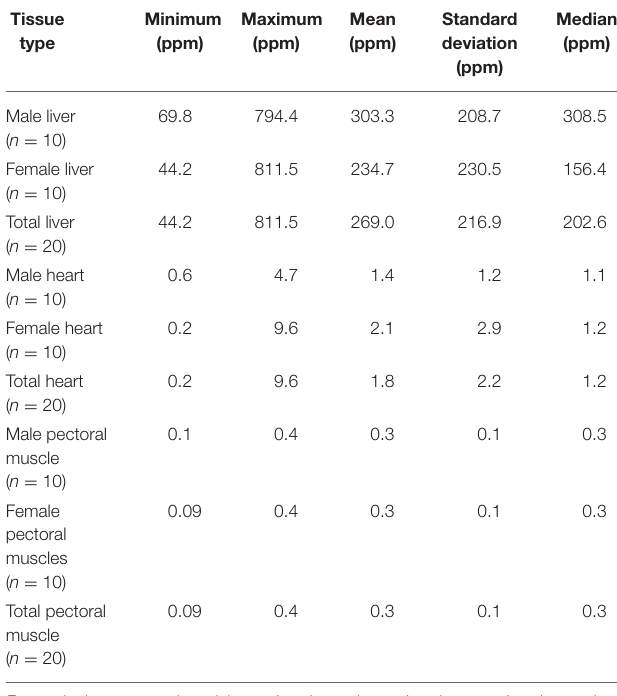
TABLE 1 | Summary statistics for retinol wet mass concentrations in liver, heart, and pectoral muscle samples from after-hatch year Anna’s Hummingbird carcasses ( n =